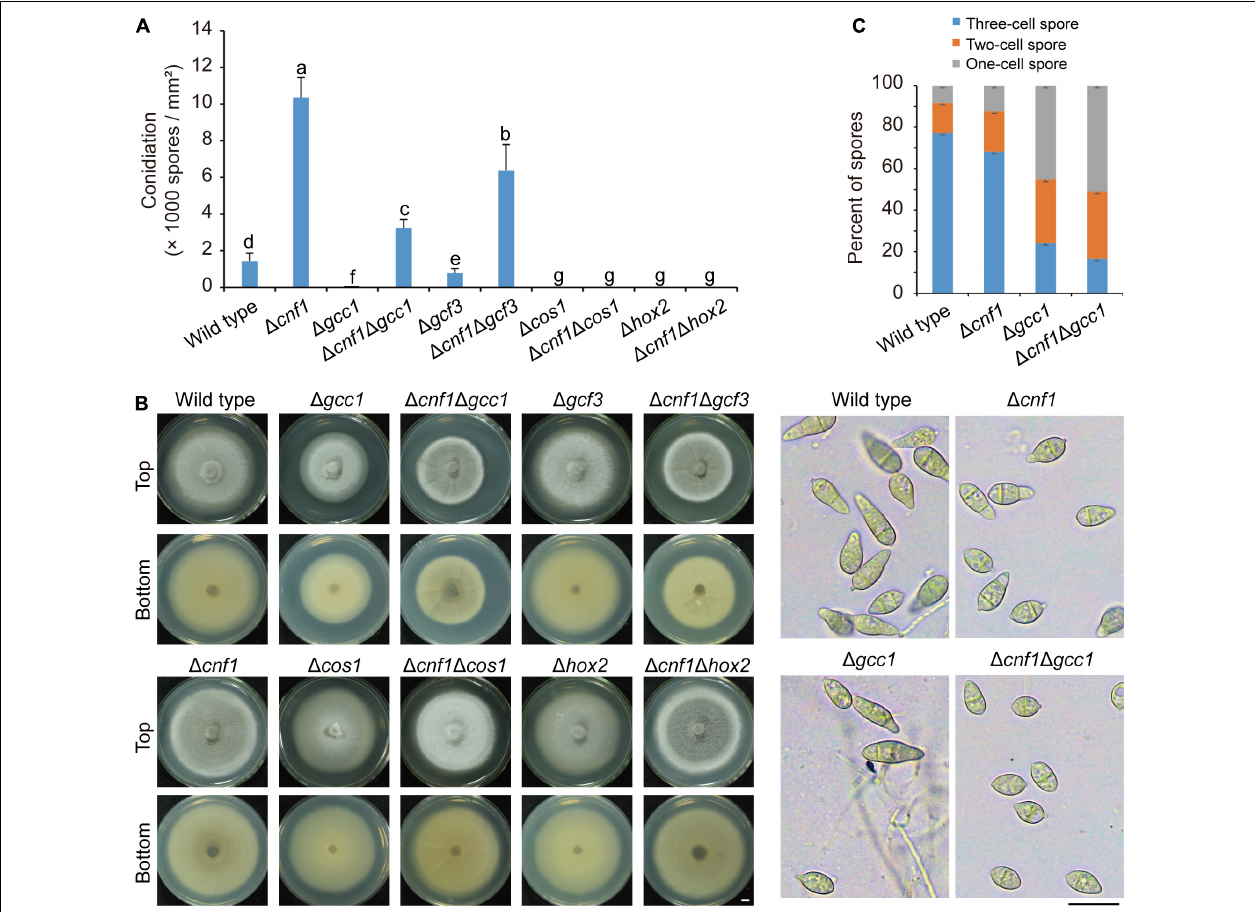
FIGURE 5 | Diverse roles of five transcription factors in regulating conidiation and melanin synthesis in M. oryzae . (A) Conidiation in the wild-type 70-15, and its derived mutants ( (cid:49) cnf1, (cid:49) gcc1 , (cid:49) cnf1 (cid:49) gcc1 , (cid:49) gcf3 , (cid:49) cnf1 (cid:49) gcf3 , (cid:49) cos1 , (cid:49) cnf1 (cid:49) cos1 , (cid:49) hox2 , and (cid:49) cnf1 (cid:49) hox2 ). Error bars represent ± SD. Different lowercase letters represent significant differences between strains as estimated by Tukey’s HSD test ( p < 0.05). (B) Images of colonial morphology and color of the wild-type 70-15 and its derived mutants. Bar = 5 mm. (C) Spore morphology of the wild-type 70-15 and its derived mutants. Upper, percentage of spores with one cell, two cells, and three cells. More than 120 spores were counted for each strain. Error bars represent ± SD. Lower, spore morphology. Bar = 20 µ